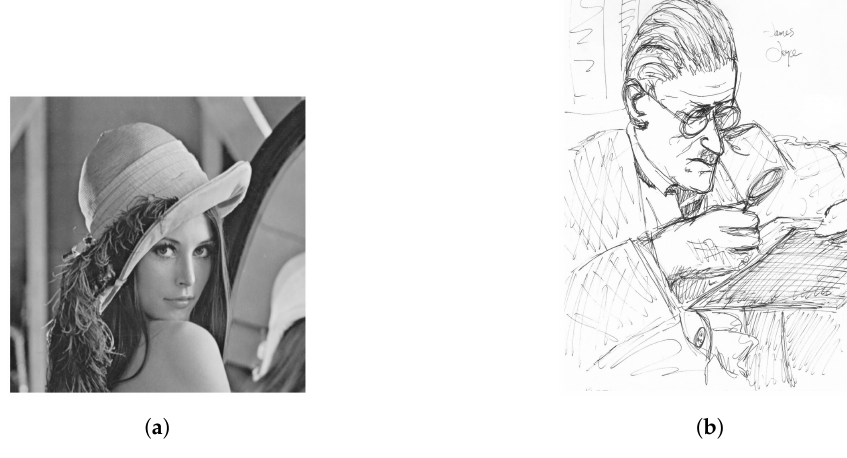
Figure 26. Test images, Part 3. ( a ) Lena, 512 × 512; ( b ) sketch [31], 1080 ×